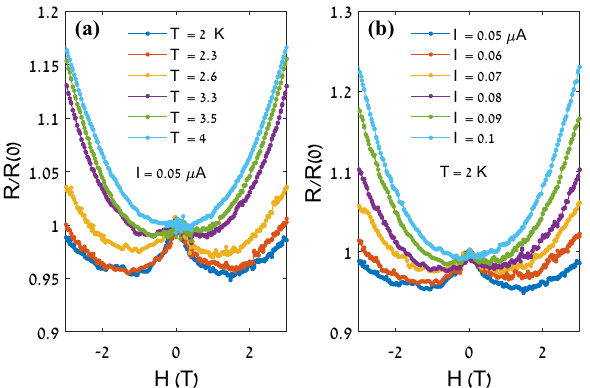
Figure 3. Magnetoresistance behavior of the NbN nanowire, at different temperatures ( a ) and different transport currents ( b ).